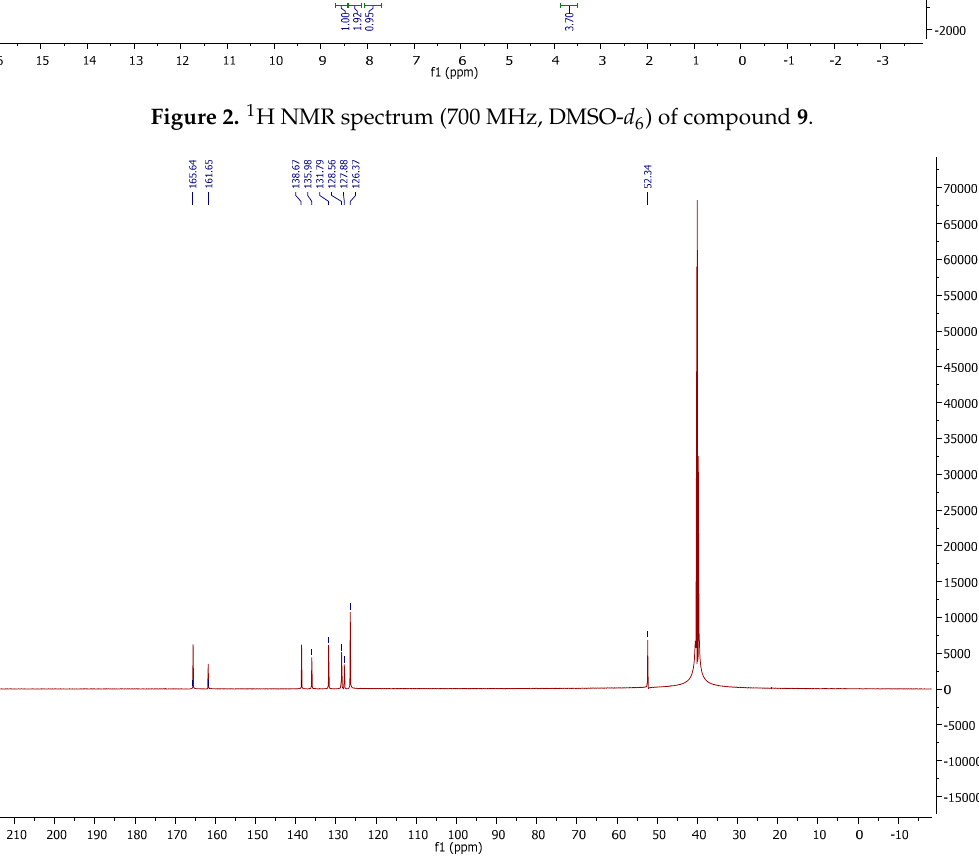
Figure 3. 13 C NMR spectrum (175 MHz, DMSO ‐ d 6 ) of compound